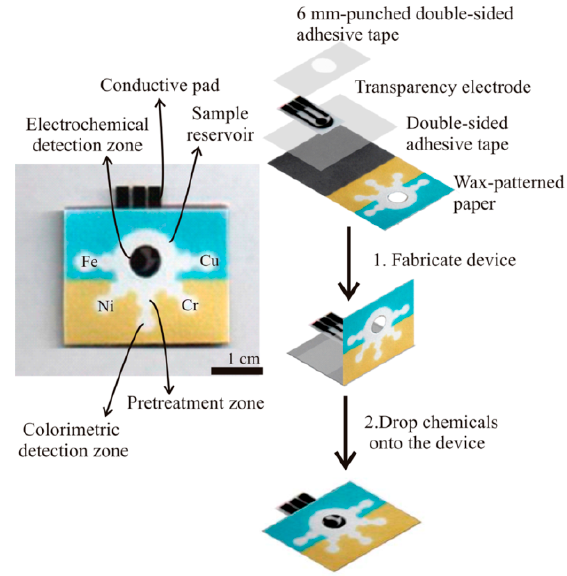
Figure 3. Fabrication process and sensor layout developed by Rattanarat et al. for metal detection. Reproduced with permission from [11], Copyright American Chemical Society 2017.